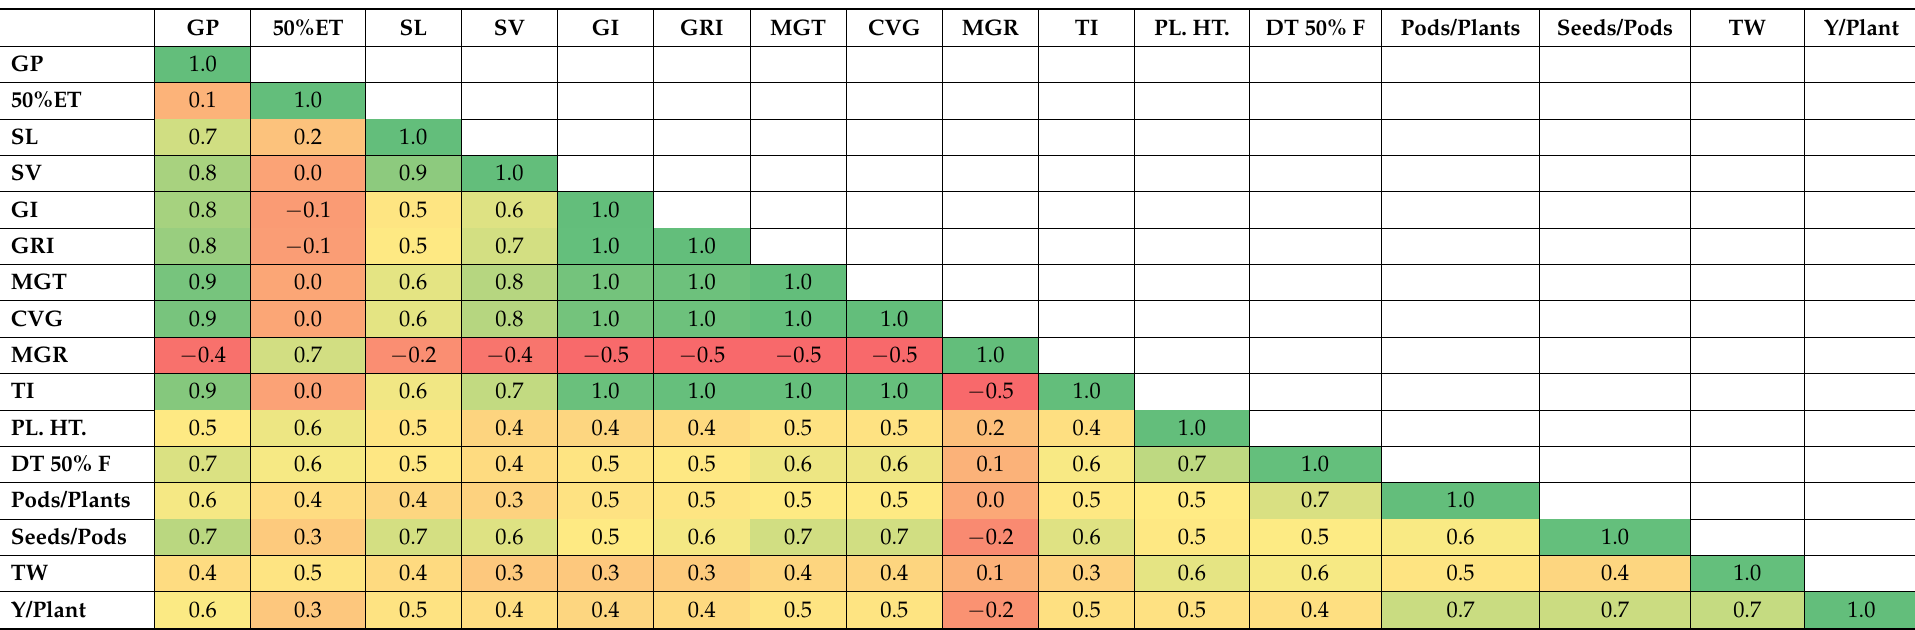
Table 1. Correlation of analysis of phenotypic parameters at vegetative, reproductive stages. Two-tailed correlation was determined from phenotypic data of germination, vegetative, and reproductive stages. PL.HT: Plant Height, TW: 100 Test weight, SV: Seedling Vigor, SL: Shoot Length, CVG: Coefficient of Velocity of Germination, MGT: Mean Germination Time, GRI: Germination Rate Index, GI: Germination Index, GP: Germination Percentage, MGR: Mean Germination